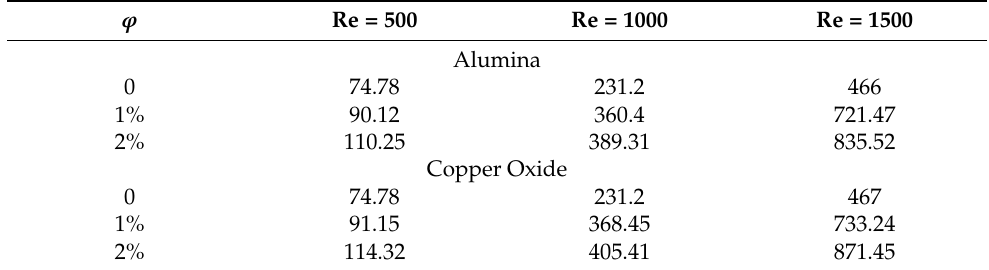
Table 2. Pressure drop in heat sink at different Reynolds numbers for two different nanoparticles.